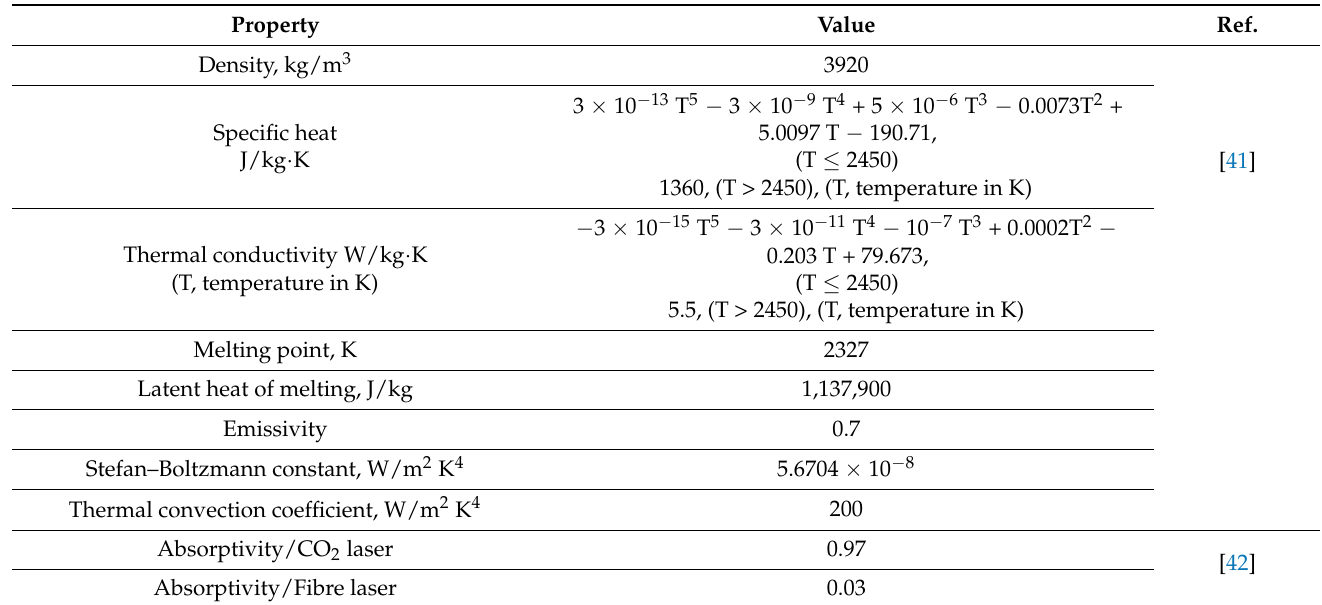
Table 1. Physical and thermal properties of alumina